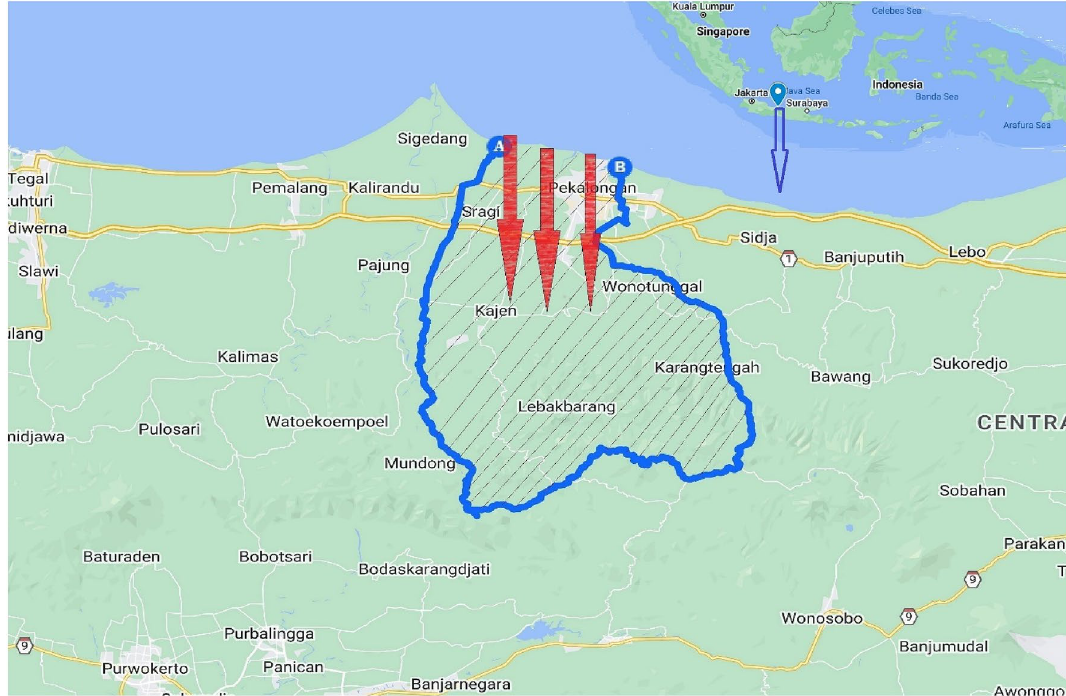
Figure 1. Pekalongan, Central Java, Indonesia 31 . The shaded area is Pekalongan and red lines show inundated areas after tidal